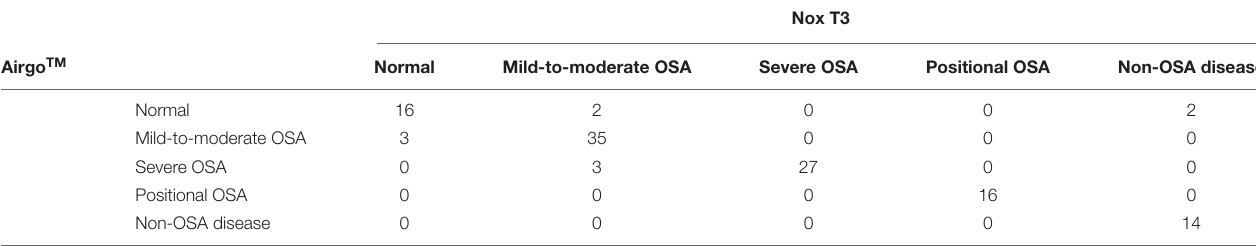
TABLE 2 | Comparison of diagnosis obtained with Airgo TM vs. Nox T3 (confusion matrix).